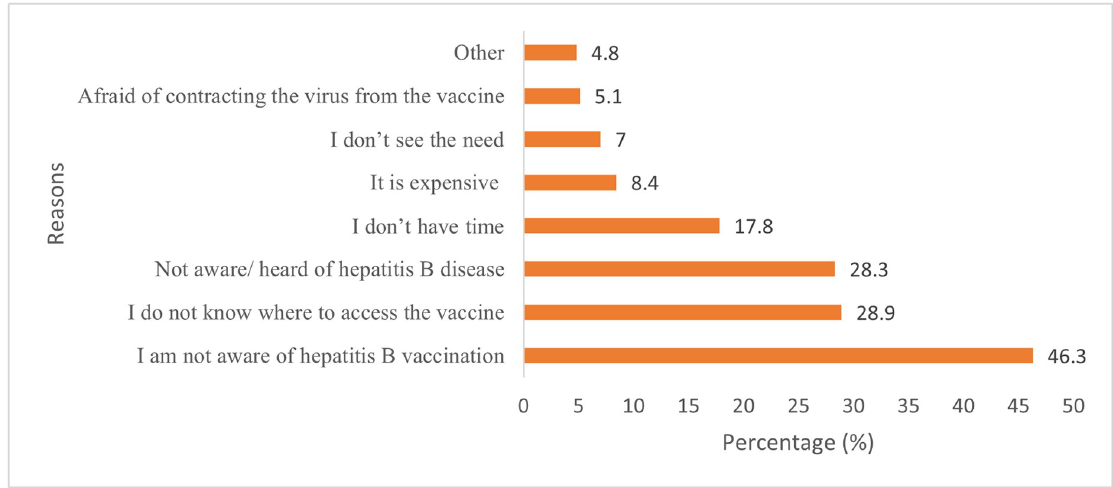
Fig 3. Reasons young psychoactive substance users in Kampala’s informal settlements gave for not being vaccinated against hepatitis